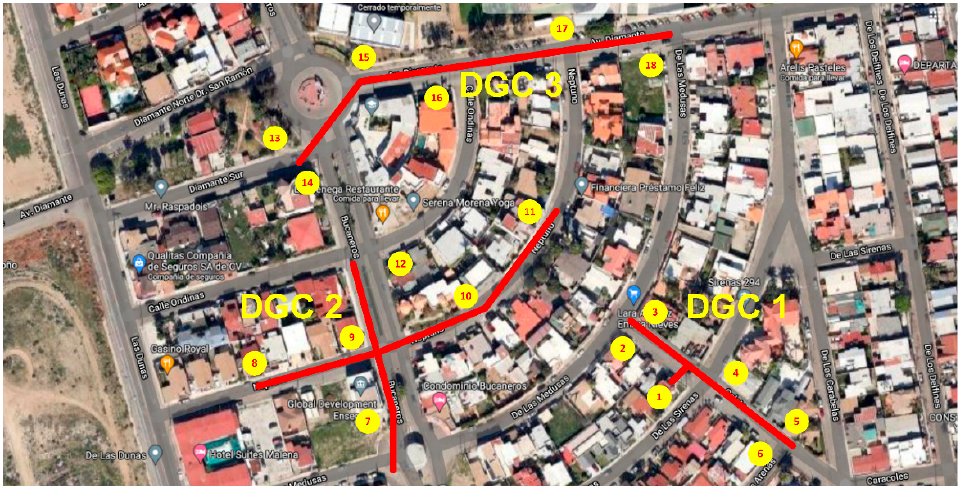
Figure 3. Location of distributed generation circuits and Active Buildings that meet the Passivhaus criteria. The solid red line represents overhead electrical wiring. Adapted from Google Maps, 2021.